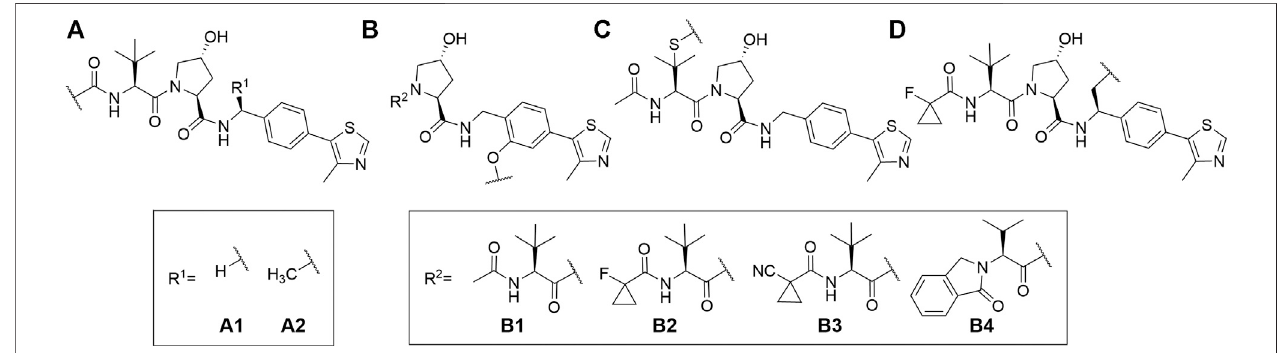
FIGURE 4 | VHL ligands found in PROTACs. Linker attachment options are represented with curly bonds and are: (A) via an amide bond after tert -leucine; (B) phenolic linkage point at the benzene ring; (C) via a thioether at the left-hand side amino acid; (D) via the benzylic methylene group.